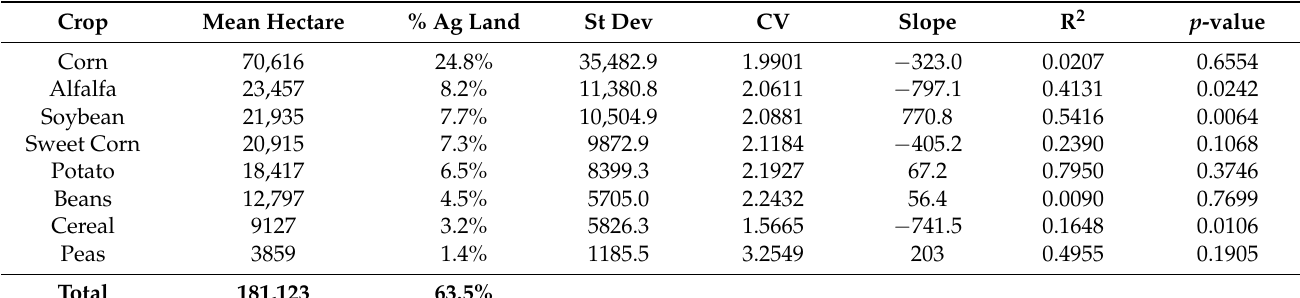
Table 2. The dominant crops found in the Central Sands and their respective mean hectares and percent coverage of agricultural land. Standard deviation indicates the extent of deviation from the mean each rotation has; the CV is the coefficient of variation of annual average variability across all years; the slope, R 2 , and p -value are from linear regression and indicate the change in hectares planted during the study period, how well this change represents the data, and whether this change is